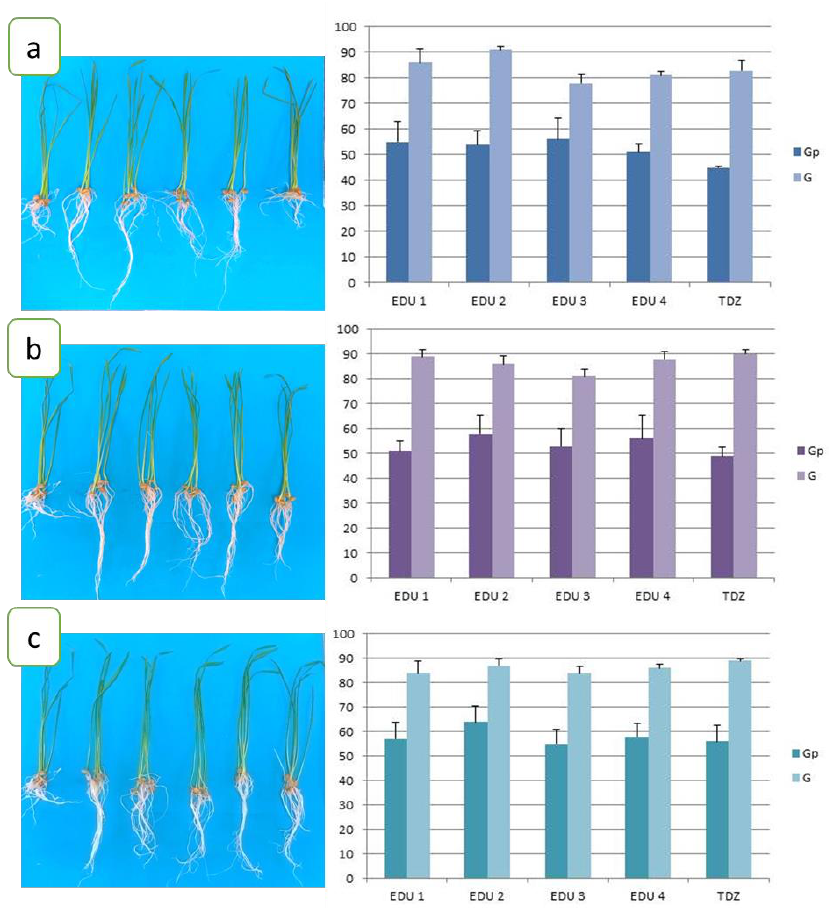
Figure 2. Appearance of wheat shoots, germination potential and germination of tested compounds at different concentrations (( a ) — 4 × 10 −3 М, ( b ) — 4 × 10 −5 М, ( c ) — 4 × 10 −7 М). at different concentrations (( a )—4 × 10 − 3 M, ( b )—4 × 10 − 5 M, ( c )—4 × 10 − 7